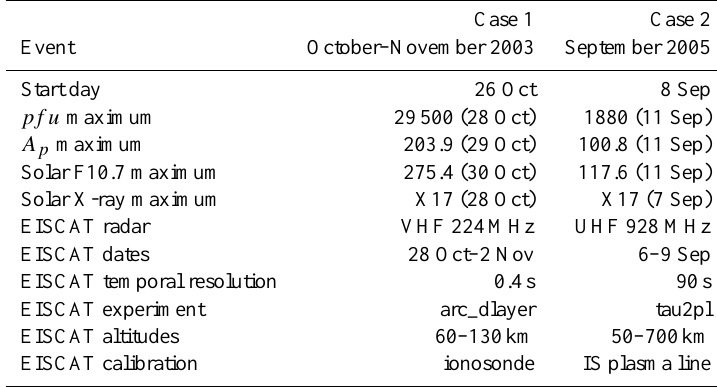
Table 1. Selected characteristics of the data and the events. pfu: proton flux unit ( > 10MeVprotonscm − 2 s − 1 sr − 1 ). Magnetic Ap index is an indicator of the magnitude of electron